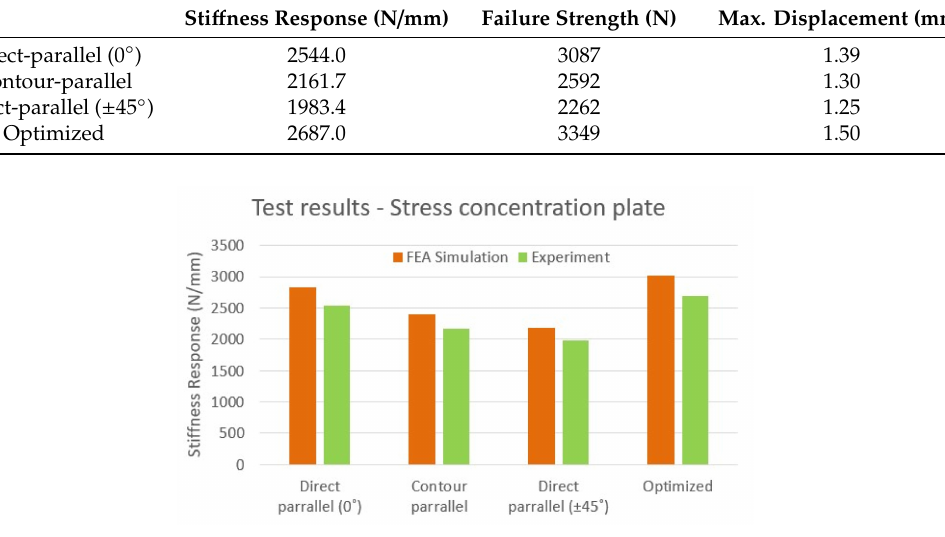
Figure 23. Comparison of stiffness response between finite element analyses (FEA) simulations and experiments.